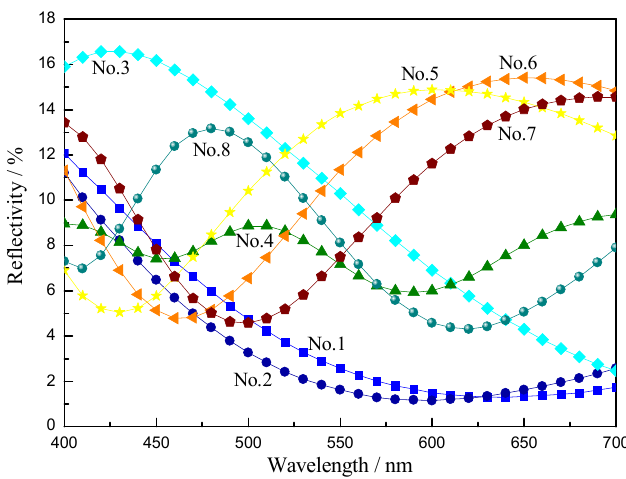
Figure 4. Reflection spectra of the samples coated with Al/TiO 2 composite films. The spectral reflectance curves of Nos. 1 and 2 samples were close to each other, but they were slightly offset. The maximum reflection wavelength was approximate 400 nm, which is in the purple and blue wavelength range. Therefore, the colors of Nos. 1 and 2 samples were determined to be bluish violet and blue, consistent with the fabric colors presented in Figure 3b,c. The center wavelength of the reflectivity curve of the No. 3 sample was located at 420 nm, which is in the blue wavelength range. Therefore, the No. 3 sample color was cyan, which is also consistent with the fabric color in Figure 3d. The maximum reflection wavelength of No. 4 sample was 510 nm, which is in the green wavelength range, and was therefore consistent with the fabric color in Figure 3e. The maximum reflection wavelengths of No. 5 sample, No. 6 sample and No. 7 sample were 600 nm, 650 nm, and 690 nm, respectively corresponding to yellow, yellowish red, orange color, and consistent with the results in Figure 3f,g,h. The maximum reflection wavelength of No. 8 sample was 480 nm, corresponding to blue-green color, and consistent with the result in Figure 3i.